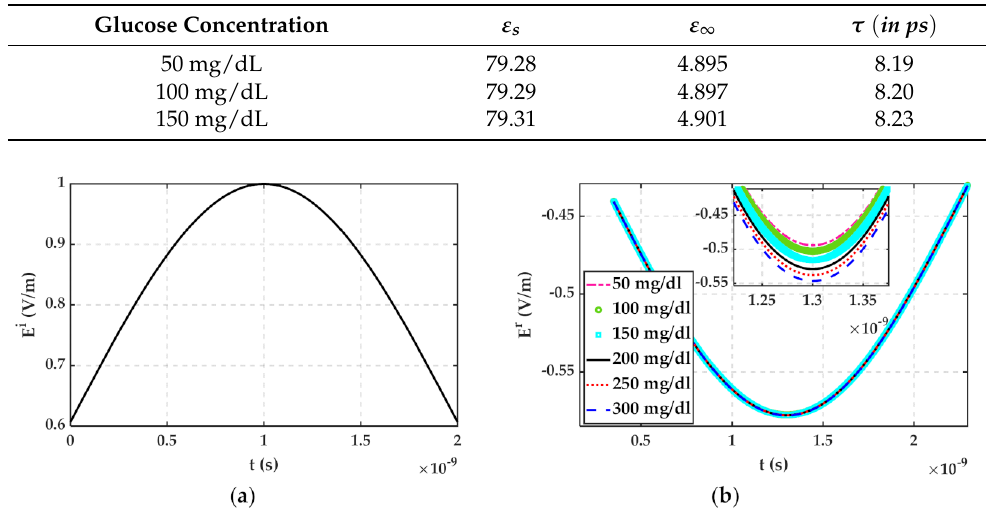
Figure 2. ( a ) Incident field to glucose concentration half-space medium ( b ) Reflected field from different glucose concentration